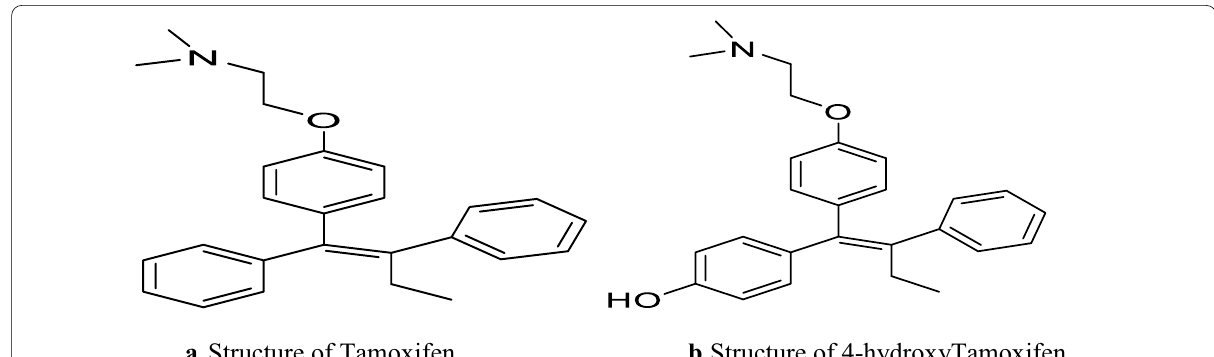
Fig. 1 a Structure of Tamoxifen, b structure of